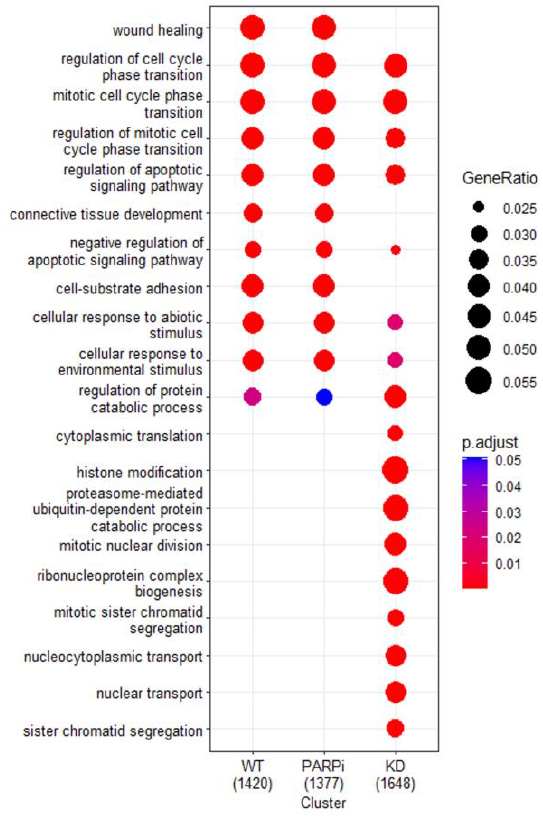
Figure 4. Prediction of PARP1 and PARylation circRNA–miRNA–mRNA regulatory network. Dot plot comparison of differential GO biological processes regulated by predicted circRNA–microRNA interactions for circRNAs unique for WT (column 1), PARPi (column 2), and PARP1 KD (column 3). The most frequent miRNA targets in each experimental circRNA group were identified from miRTarBase (Release 9.0) [24] relative to human miRNA seeds. The target functional annotation was completed using clusterProfiler.